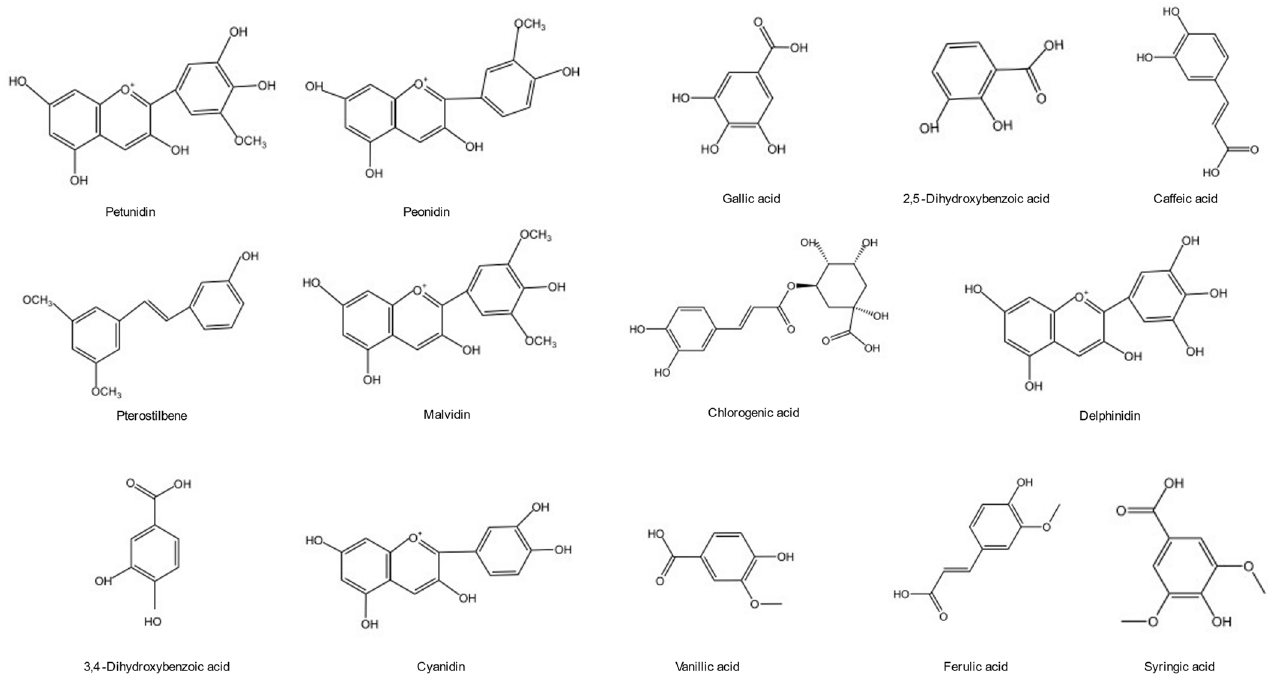
Figure 2. Chemical structure of the main phenols in the blueberry.